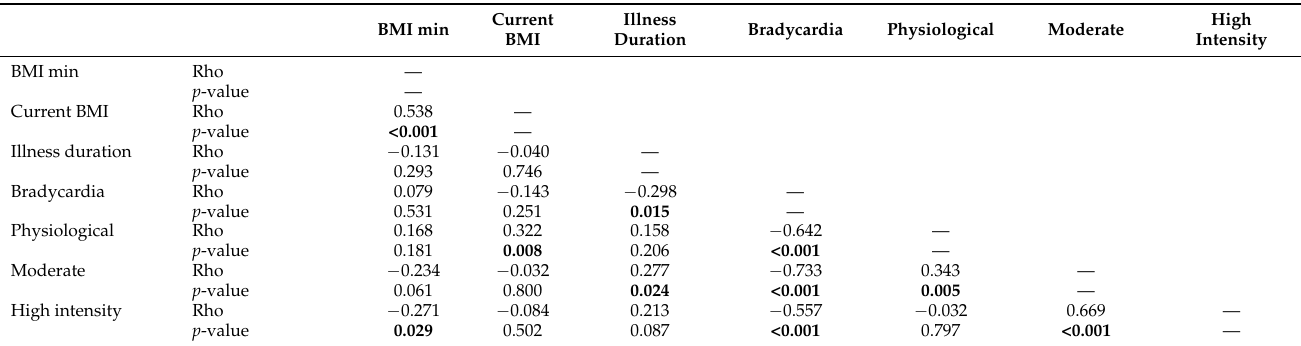
Table 4. Non parametric correlation for BMI minimum, current BMI, illness duration and heart rate ranges in all patients with (AN n = 68). Significant p -values are in bold. BMI: body mass index; EDI: Eating Disorder Inventory II; HADS: Hospital Anxiety and Depression scale; YBS: Yale Brown Scale. BMI min Current BMI Illness Duration Bradycardia Physiological Moderate High Intensity